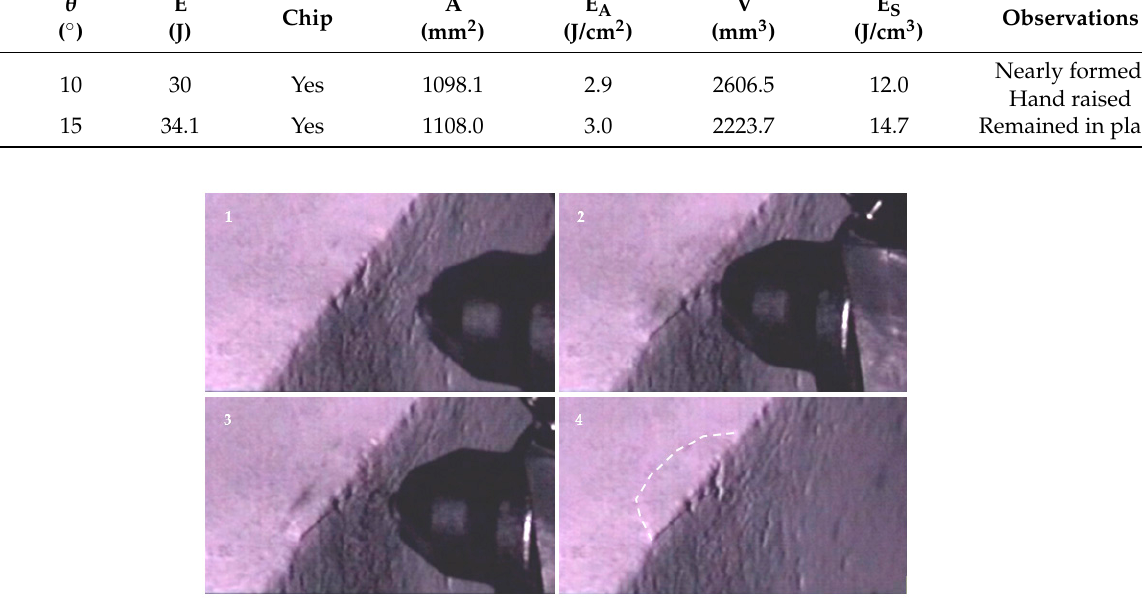
Figure 12. Test 1: Impact energy of 30 J. 1 . Approximation of the pick to the test sample. 2 . Hitting of the pick on the test sample. 3 . Distance of the pick from the test sample. 4 . Deformation of the test sample.